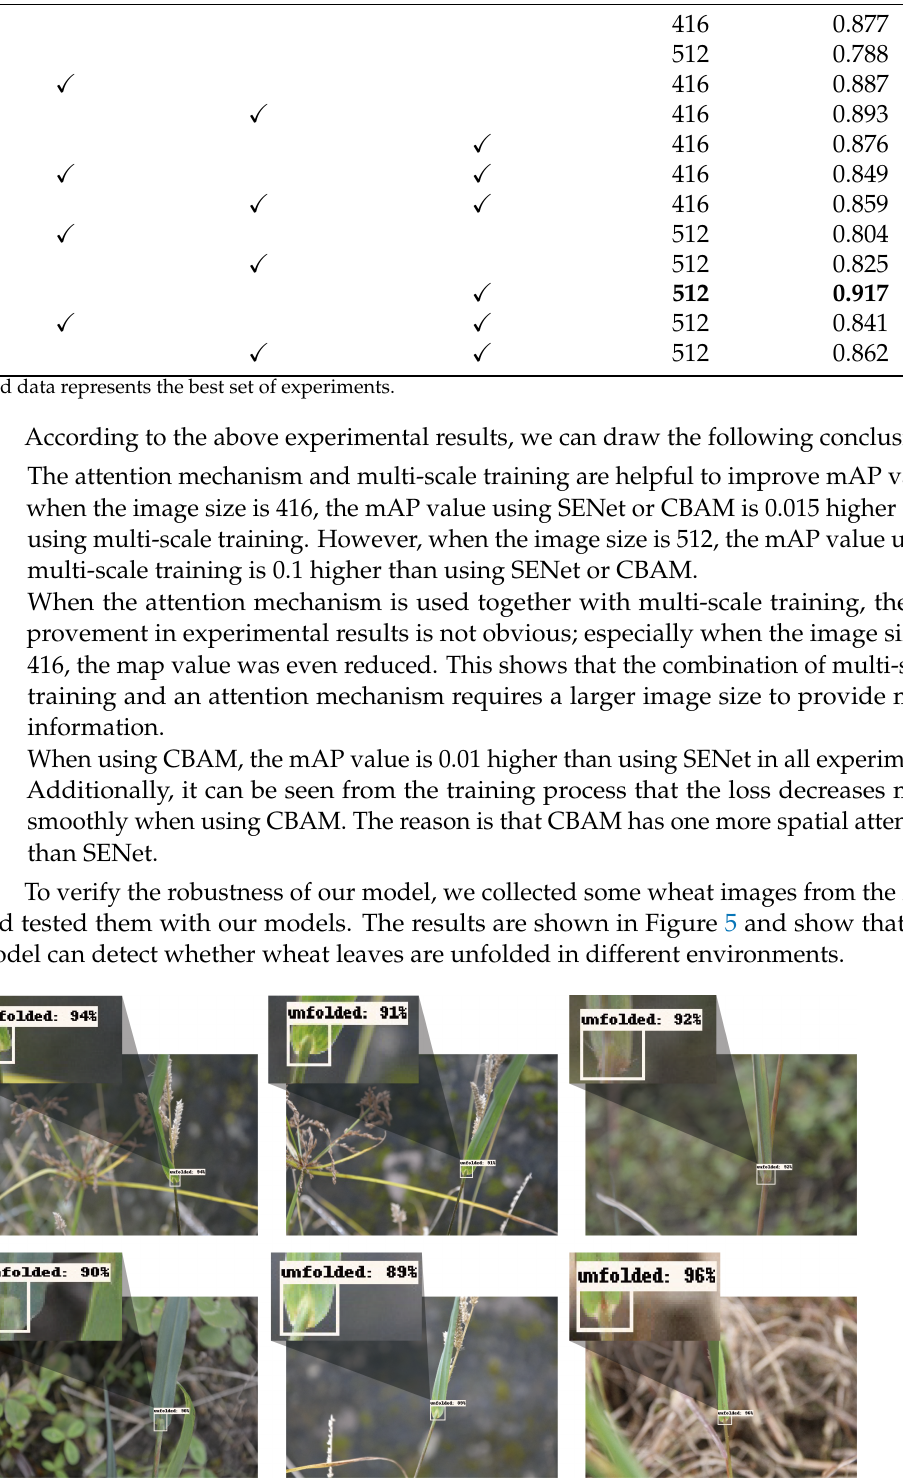
Figure 5. The test results of wheat images collected from the field. The crease between the wheat leaf and the main stem indicates that the wheat leaf has been fully unfolded, and the crease is the target of detection. The probability in the figure is the confidence score. In the experiment, we set the threshold to 85%. When the confidence score is higher than 85%, the leaf is considered to be